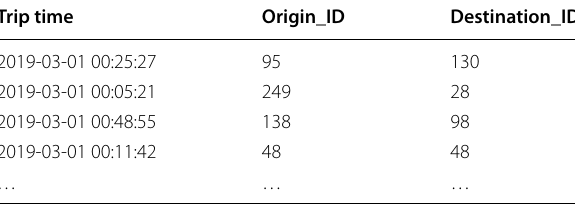
Table 1 Exemplifying overview of the trip data format